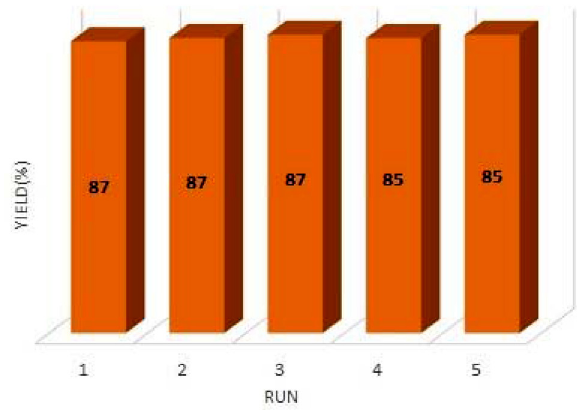
Figure 1. Recovery and reuse of Cu/C nanoparticles for the synthe- sis of 5-phenyl-1 H -tetrazole from benzaldehyde via benzonitrile.